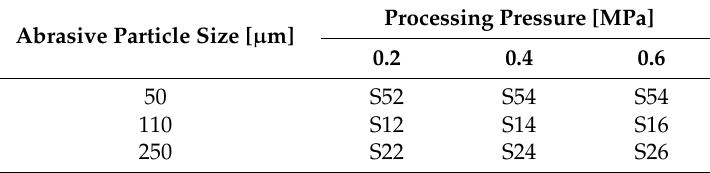
Table 3. The parameters of abrasive blasting